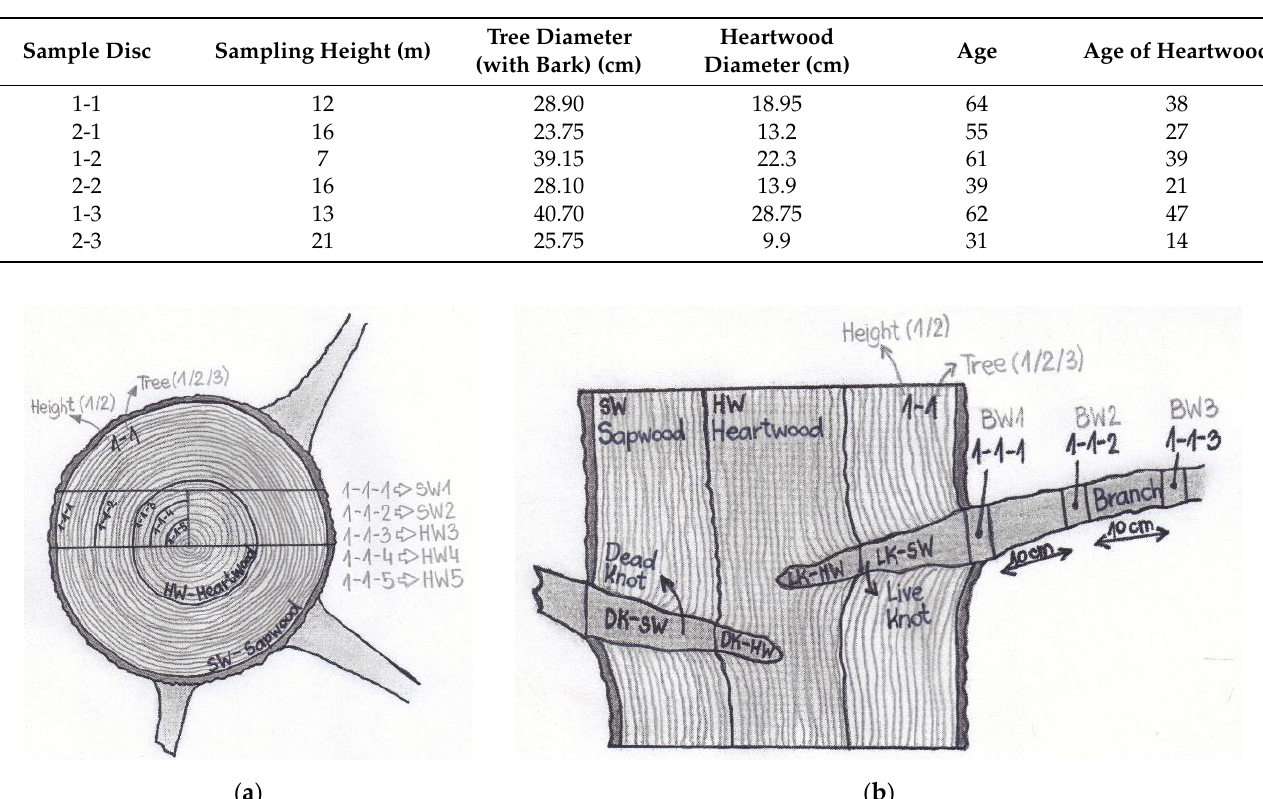
Table 1. Information on sample discs of silver fir ( A. alba ).